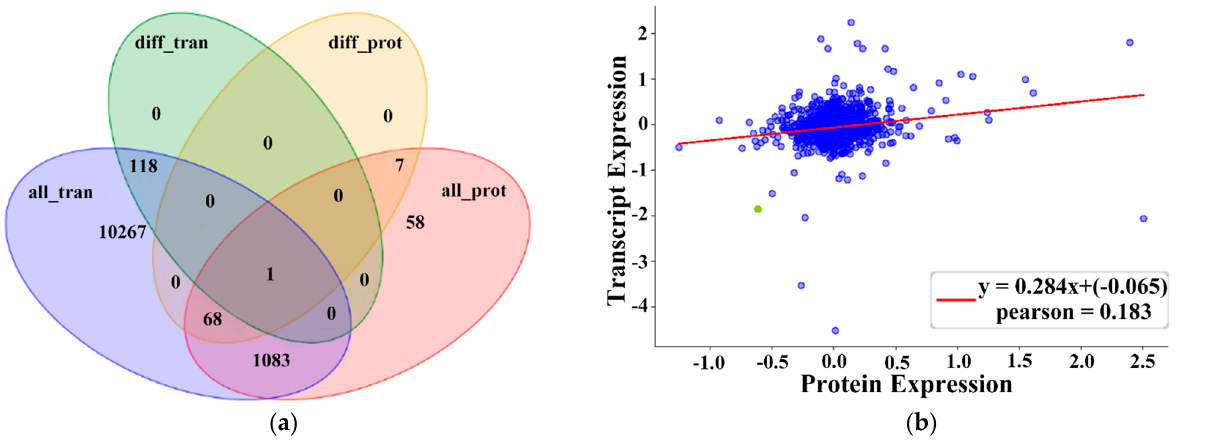
Figure 6. Venn diagram of all differentially transcribed genes and differentially translated proteins and correlation analysis of transcriptome and proteome expression levels in skeletal muscle samples from CON–G and HFD–G rabbits. ( a ) In Venn diagram, blue (all_tran) represents all genes obtained from transcriptome, green (diff_tran) represents differentially expressed genes identified by the transcriptome, red (all_prot) represents all proteins identified by the proteome, and orange (diff_prot) represents differentially expressed proteins identified by the proteome. ( b ) In correlation analysis graph, green dot represents significant differentially expressed protein and blue dot represents nonsignificant differentially expressed protein. Abscissa represents differentially translated proteins (log 2 FC) and ordinate represents differentially transcribed genes (log 2 FC) in skeletal muscle samples from CON–G and HFD–G